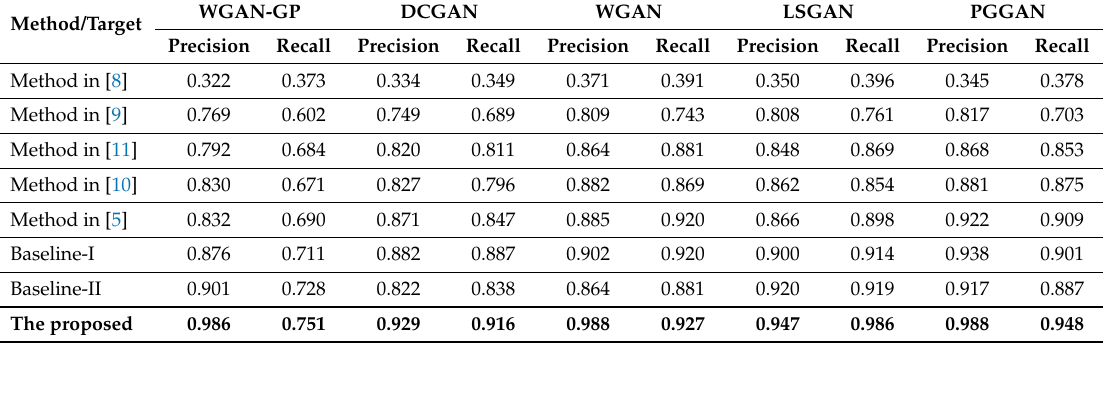
Table 3. The objective performance comparison of the proposed and other fake face detectors.